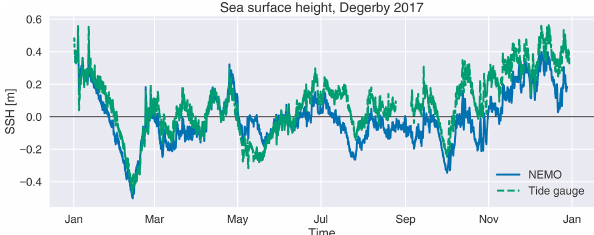
Figure 2. Sea surface height at the Föglö Degerby tide gauge in 2017, showing a comparison between measurements and the